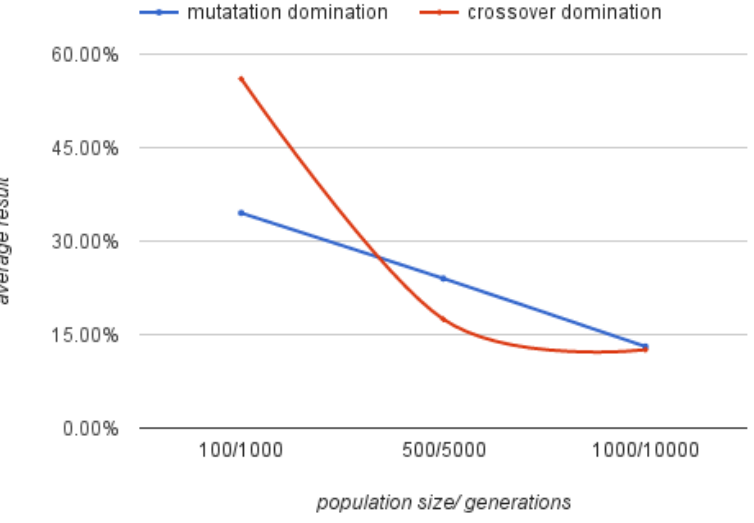
Figure 17. Dominant mutation and crossover descent plotted